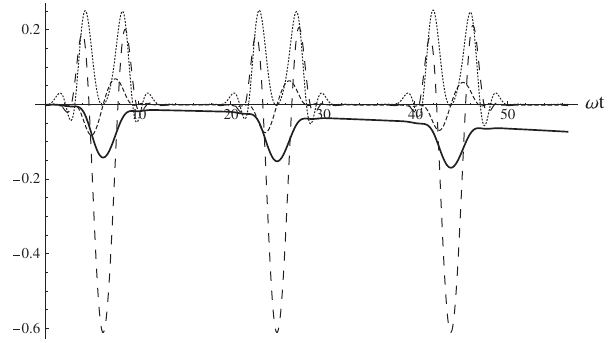
FIG. 4. Position of the particle along kz (black continuous line; kz ¼ 2 π corresponds to z ¼ λ ) and β z of the particle (short- dashed line) as a function of ω t . Beam and laser parameters are the same as for Fig. 3. The long-dashed and dotted lines show the ~ B = 30 and ~ E = 30 experienced along the values of y z